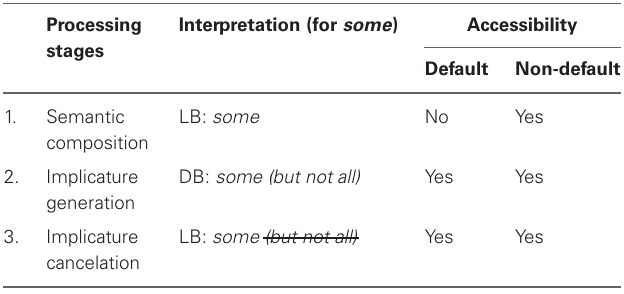
Table 2 | Processing stages assumed by the default and non-default